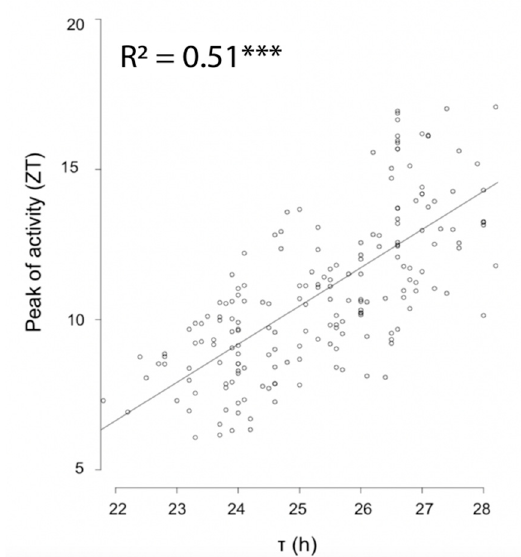
Figure 3. Correlation between peak of activity and free running period. Free running period ( τ ) of southern and northern Nasonia vitripennis . Asterisks indicate a significant e ff ect of activity timing on free running period (*** p < 2e-16, linear mixed e ff ect